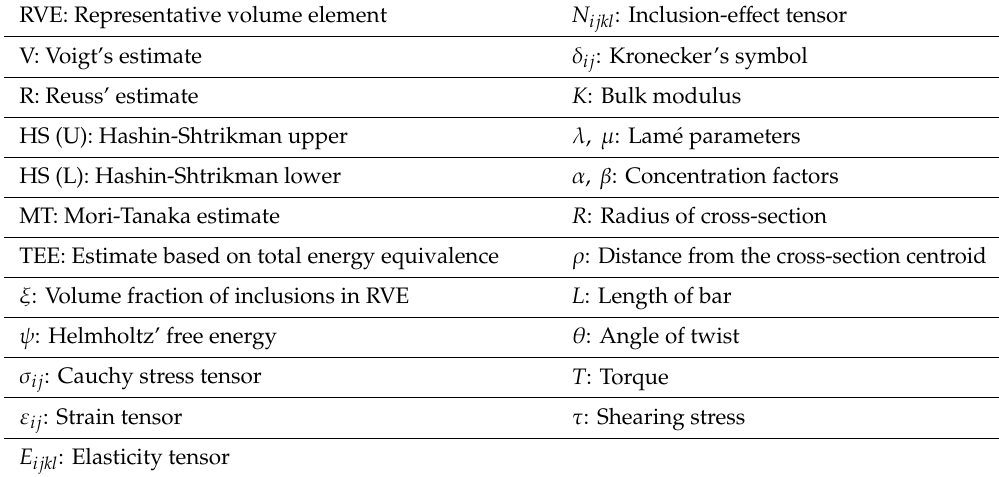
Table 1. Definitions of frequently used abbreviations and